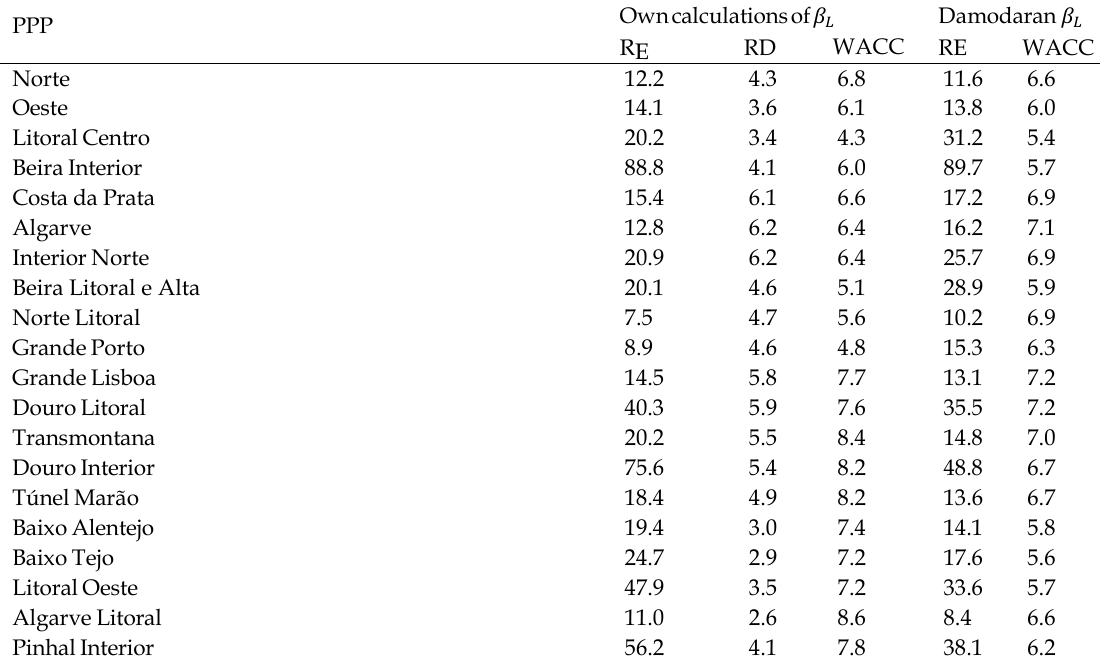
Note:This table presents the results of the CAPM (using this paper’s method and Damodaran values to calculate the levered Beta ). Re stands for the CAPM values, Rd for the cost of debt, and WACC for the weighted average cost of capital. Source: own table (organized by the concession